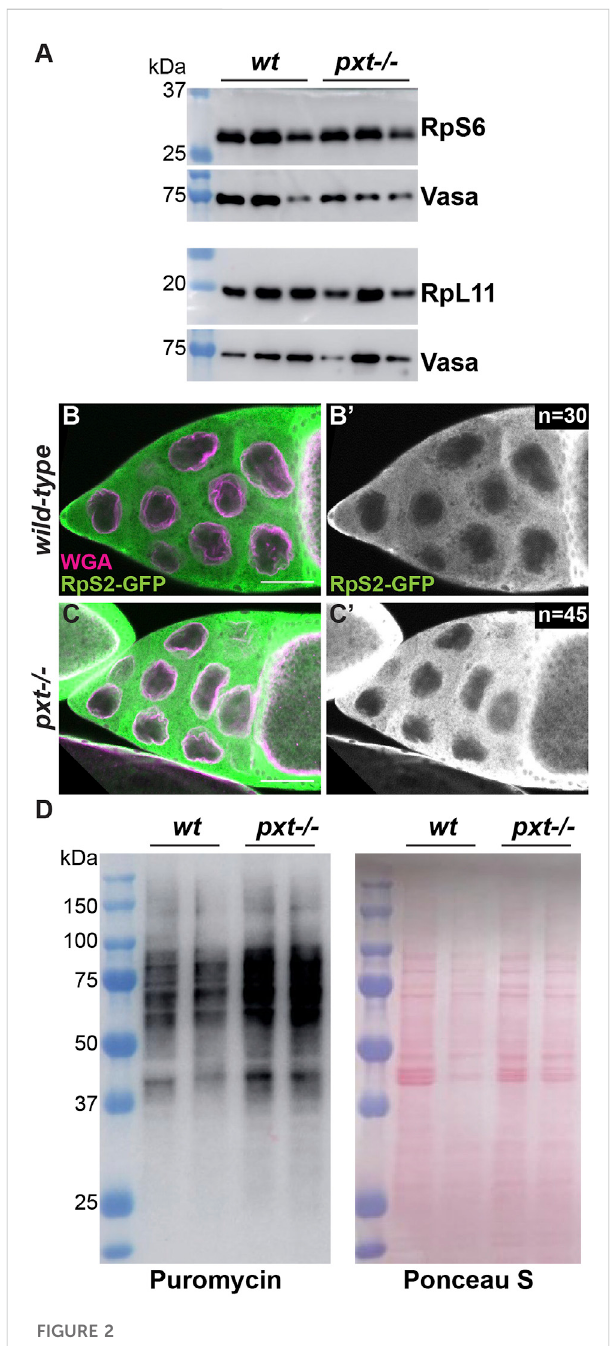
FIGURE 2 Prostaglandins restrict protein translation levels. (A) . Western blots of wild-type and pxt EY mutant whole ovary lysates for RpS6 and RpL11; the Vasa blots serve as the loading controls. For RpS6, the blot was cut horizontally at the 37 kDa ladder band, with the top stained for Vasa and the bottom for RpS6. For RpL11, two gels were loaded with the same samples. (B-C ’ ) . Single confocal slice of wild- typeand pxt f mutant S10B follicles stained for: RpS2-GFP (anti-GFP) in green in merge and white in single channel (B 9 ,C 9 ) and WGA, which marksthenuclearenvelope,inmagentainmerge.Scalebars=50 μ m. (D) .RepresentativewesternblotforPuromycinandPonceauSstained blot (loading control) of puromycin incorporation assay on wild-type and pxt EY mutant whole ovary samples. In (A,D) , molecular weight ladder (kDa) is BioRad Precision Plus Protein Standard. Loss of Pxt results in no change in RpS6 compared to RpL11 levels (A) , normal cytoplasmic localization of RpS2 (B-C 9 ) , and increased protein translation (D)